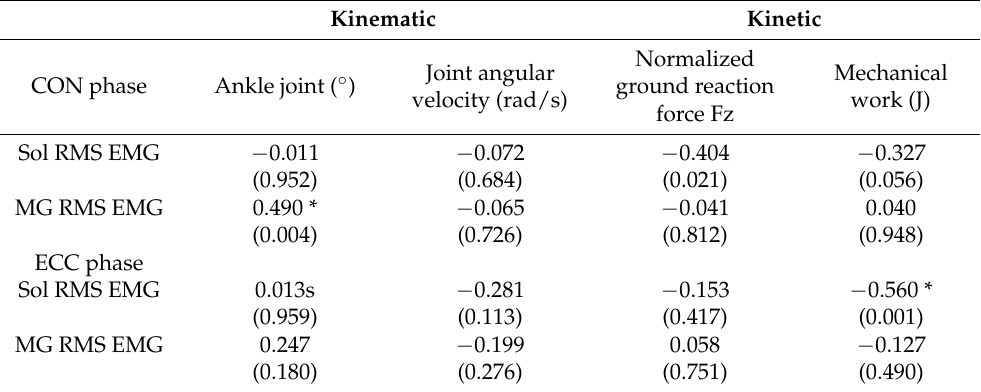
Table 3. Spearman rank correlation coefficients between the EMG results of four leg muscles and the kinetic and kinematic characteristics during the one-legged heel-raise exercise.